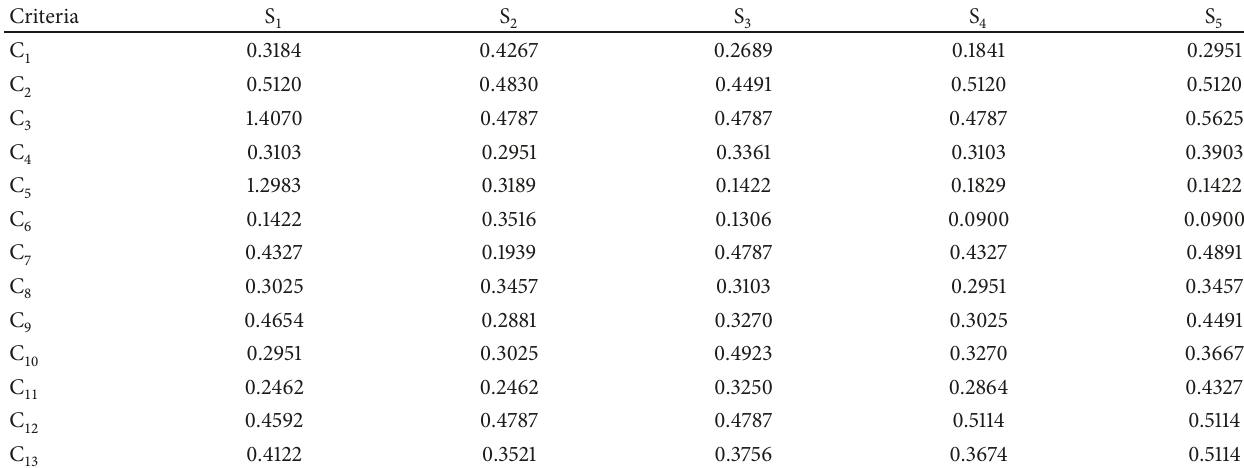
Table 11: Common area for the maintenance systems.